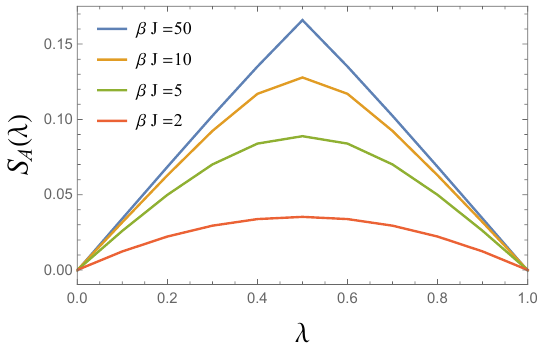
Figure 16. Renyi-2 entropy per Majorana fermion of a subset A of fermions in the left side after all fermions in the right side have been measured. The left system is in the Kourkoulou-Maldacena state. λ denotes the fraction of left fermions included in subsystem A . Different colors denote different values of β . The Renyi-2 entropy is symmetric around λ = 0 . 5 due to the purity of